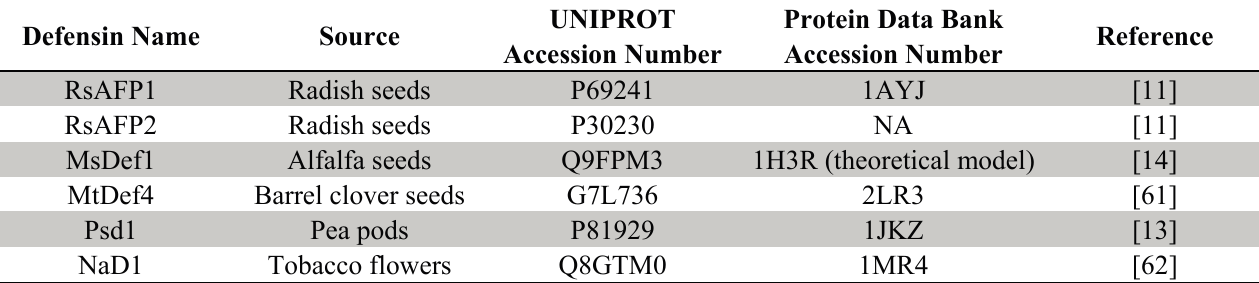
Table 1. Overview of the plant defensins discussed in this review. NA: not available.